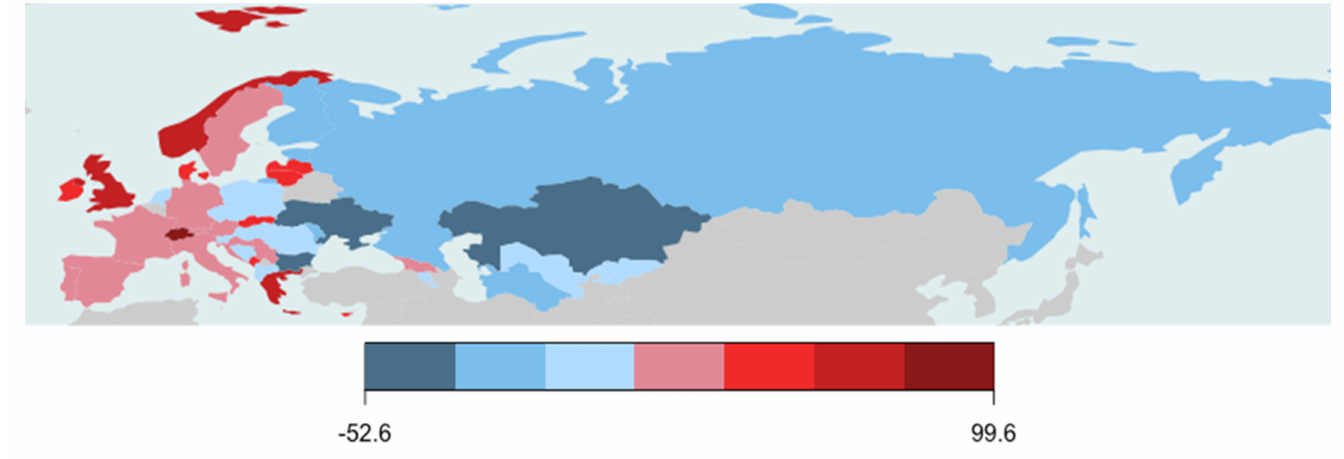
Figure 2. Net imports (negative values: exports) of embodied energy (GJ) per capita (authors’ elaboration on Eora26